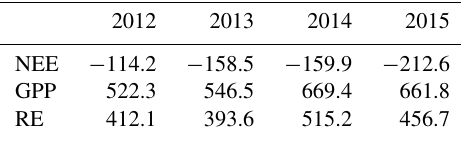
Table 4. The annual total NEE, GPP and RE (gCm − 2 yr − 1 ) for each year from 2012 to 2015.